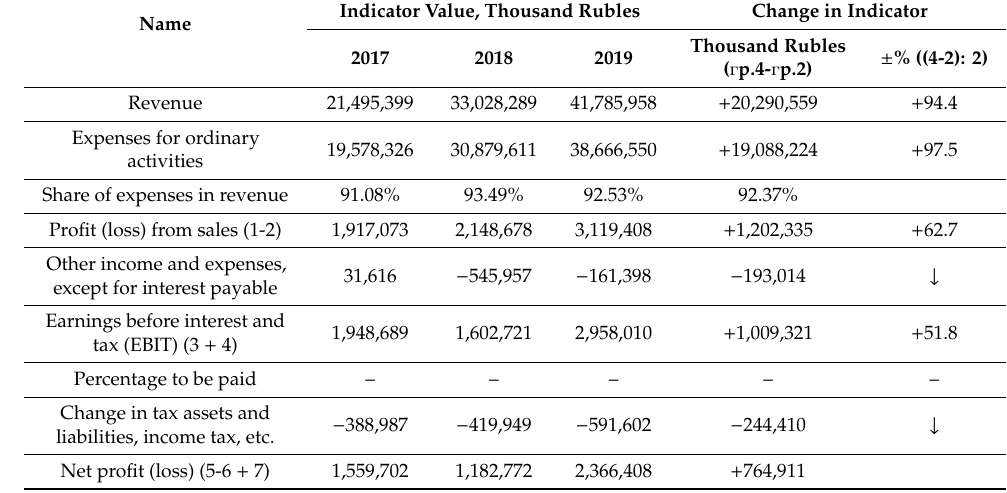
Table A3. Research results for the oil and gas industry (annual data, yearly data).